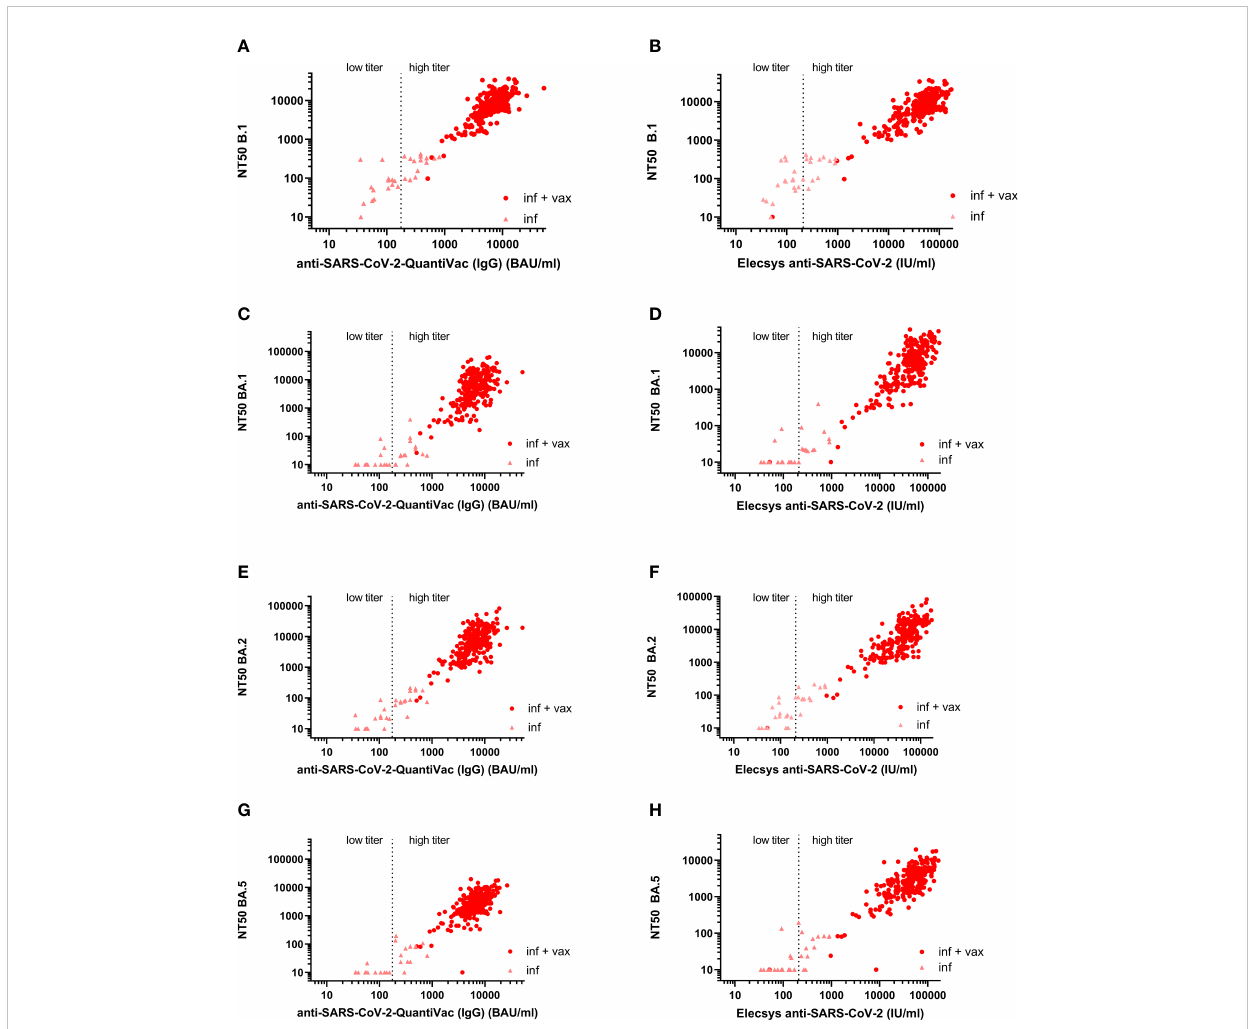
FIGURE 3 Correlation between anti-S antibody concentrations and NT50 against B.1, BA.1, BA.2, and BA.5. (A) Correlation between anti-S antibody concentrations measured by anti-SARS-CoV-2-QuantiVac-ELISA (IgG) and NT50 against B.1 (Spearman correlation 0.78). (B) Correlation between anti-S antibody concentrations measured by Elecsys Anti-SARS-CoV-2 S and NT50 against B.1 (Spearman correlation 0.79). (C) Correlation between anti-S antibody concentrations measured by anti-SARS-CoV-2 QuantiVac-ELISA (IgG) and NT50 against BA.1 (Spearman correlation 0.66). (D) Correlation between anti- S antibody concentrations measured by Elecsys Anti-SARS-CoV-2 S and NT50 against BA.1 (Spearman correlation 0.77). (E) Correlation between anti-S antibody concentrations measured by anti-SARS-CoV-2-QuantiVac-ELISA (IgG) and NT50 against BA.2 (Spearman correlation 0.70). (F) Correlation between anti-S antibody concentrations measured by Elecsys Anti-SARS-CoV-2 S and NT50 against BA.2 (Spearman correlation 0.78). (G) Correlation between anti-S antibody concentrations measured by anti-SARS-CoV-2 QuantiVac-ELISA (IgG) and NT50 against BA.5 (Spearman correlation 0.72). (H) Correlation between anti-S antibody concentrations measured by Elecsys Anti-SARS-CoV-2 S and NT50 against BA.5 (Spearman correlation 0.76). Figures (A – H) Results of non-vaccinated convalescents (inf) are shown as triangles, and results of vaccinated convalescents (inf + vax) are shown as fi lled circles. The vertical dashed line at 176 BAU/ml for the anti-SARS-CoV-2 QuantiVac and at 210 U/ml for the Elecsys anti-SARS-CoV-2 represents the threshold above which CCP is considered high-titer CCP according to the FDA ’ s recommendations for investigational CCP